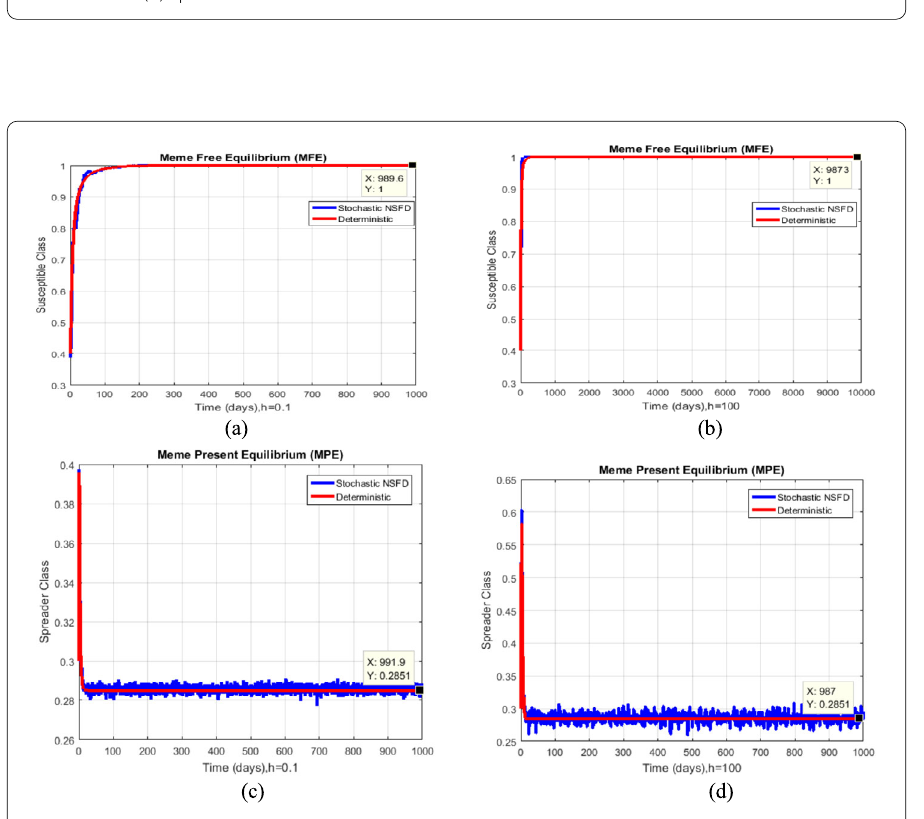
Figure 5 ( a ) Susceptible class for MFE at h = 0.1. ( b ) Susceptible class for MFE at h = 100. ( c ) Spreader class for MPE at h = 0.1. ( d ) Spreader class for MPE at h =